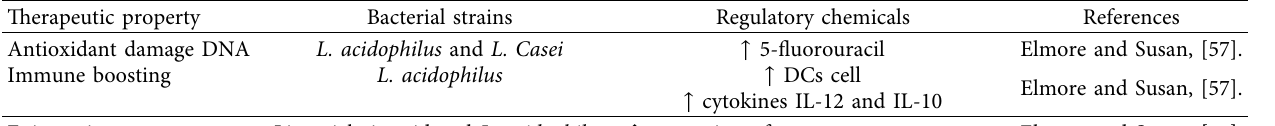
Table 2: Lactic acid bacterial strains and their function. Therapeutic property Bacterial